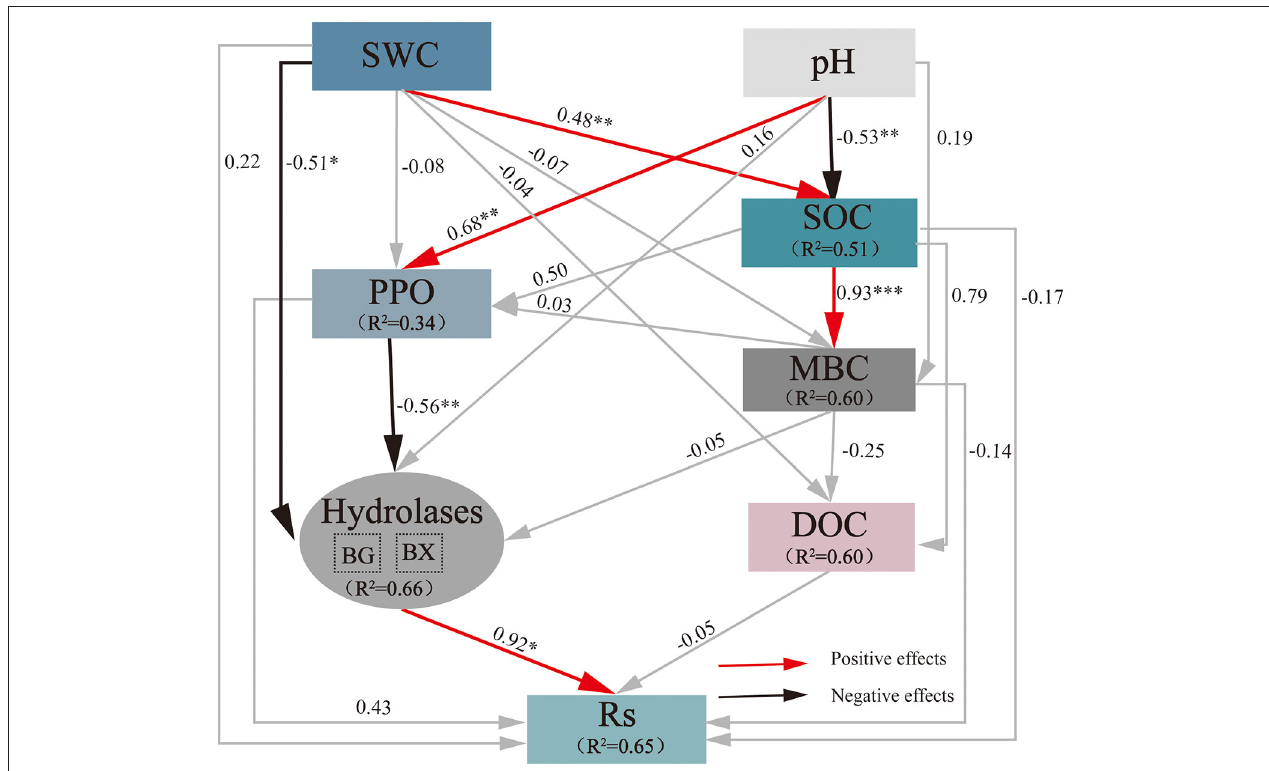
FIGURE 5 | Impacts of selected drivers on Rs under extreme drought calculated by the SEM of path analysis based on data collected in 2019. The values on the arrows are normalized path coefficients, and the asterisks after the numbers indicate remarkable correlations (* p < 0.05, ** p < 0.01, and *** p < 0.001). The rectangle R 2 value represents the ratio of variance explained by relationships with other variables. SWC, soil water content; SOC, soil organic carbon; MBC, microbial biomass carbon; DOC, dissolved organic carbon; BG, β -1,4-glucosidase; Rs, soil